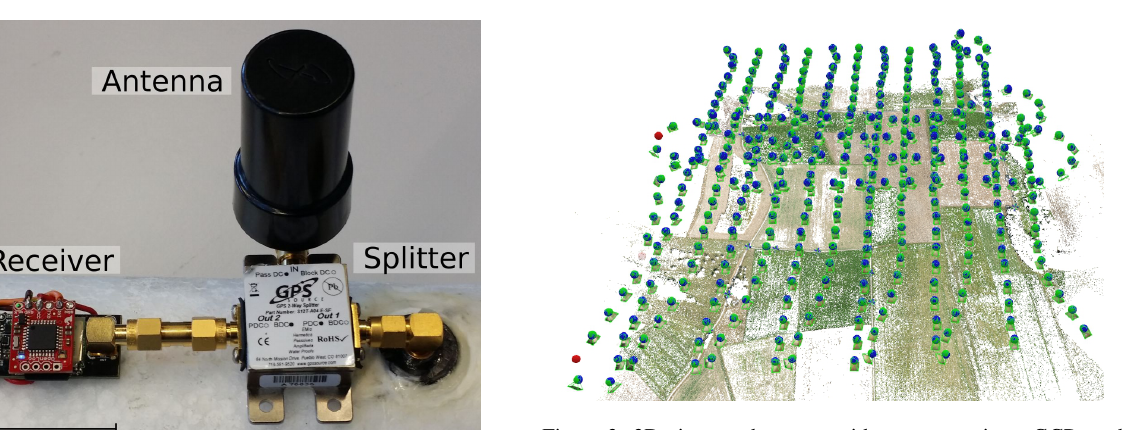
Figure 3. 3D view on the scene with camera stations, GCPs and a point cloud of tie-points from Pix4Dmapper Pro.